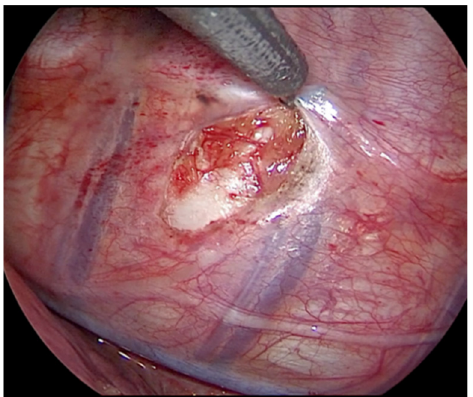
Figure 4. Thoracoscopic view: incision of the parietal pleura, lateral to the vertebral bodies and anterior to the rib heads.